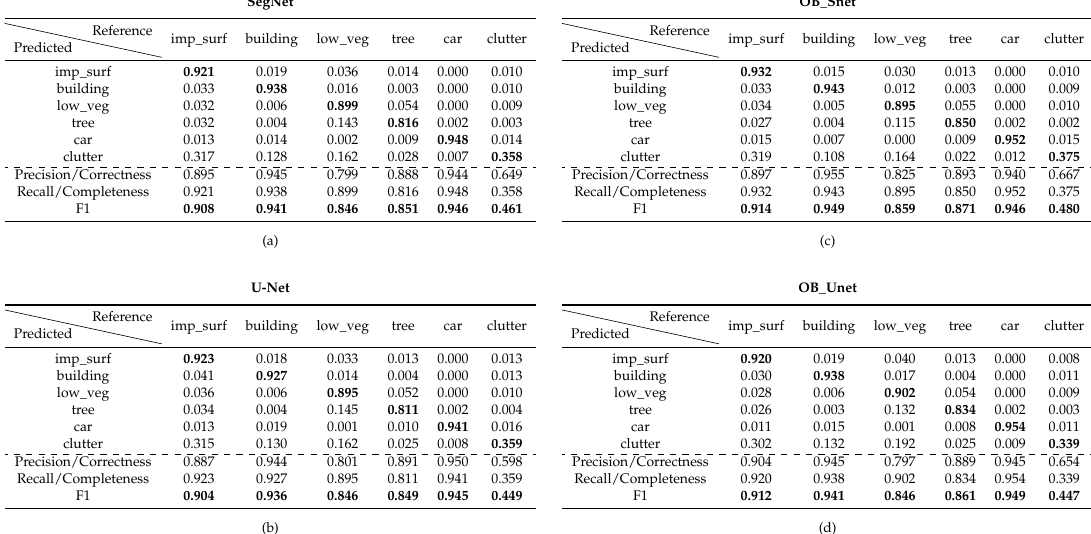
Figure 6. Resulting Confusion Matrices for the developed object-based learning frameworks (OB_Snet and OB_Unet) in the Potsdam dataset ( right ) and the corresponding ones for the fully convolutional (SegNet and U-Net) networks ( left